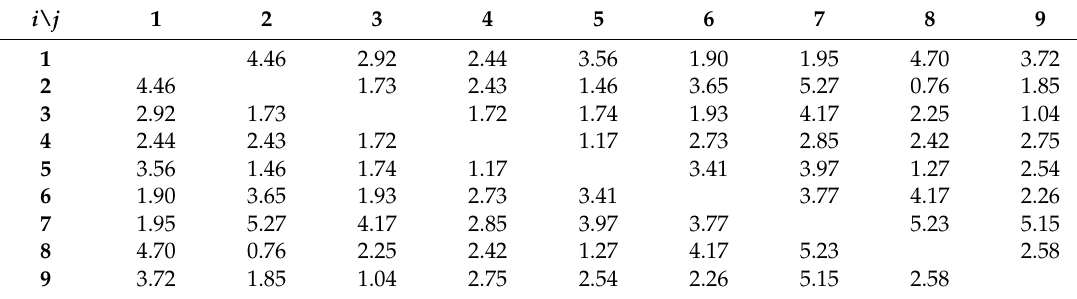
Table 2. Distances in km between two nodes (index 1 for the producer, 2 for the definite consumer, 3 to 9 for potential